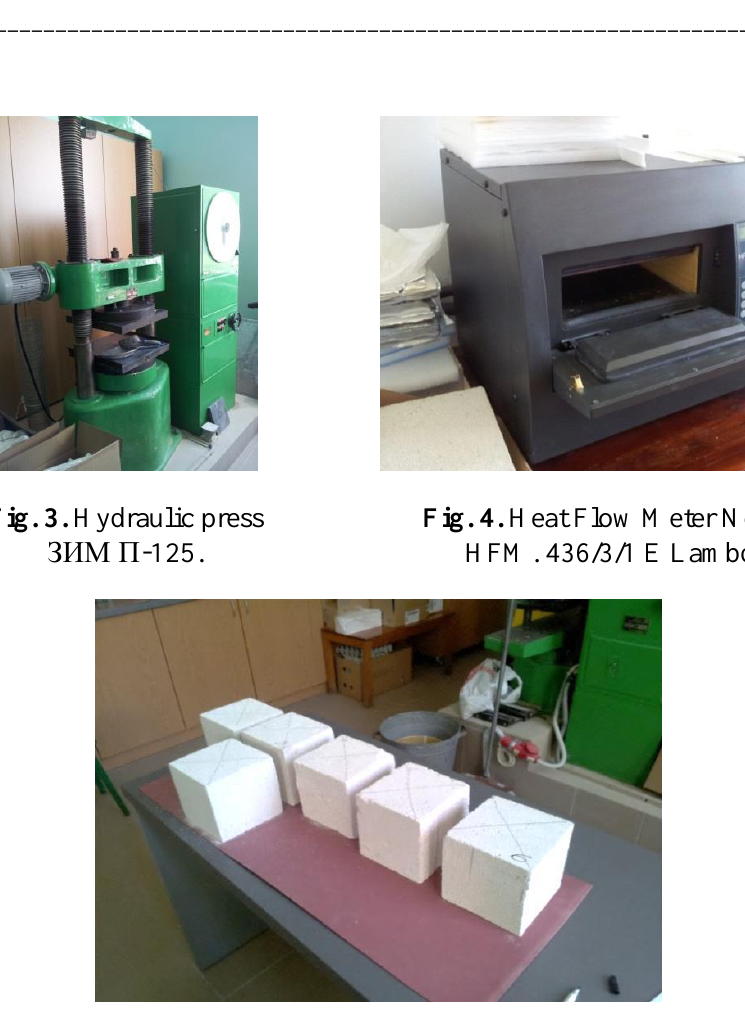
Fig. 5. Aerated concrete block samples for compressive strength test: Aeroc Classic 300 and RocLITE UNIVERSAL 300.